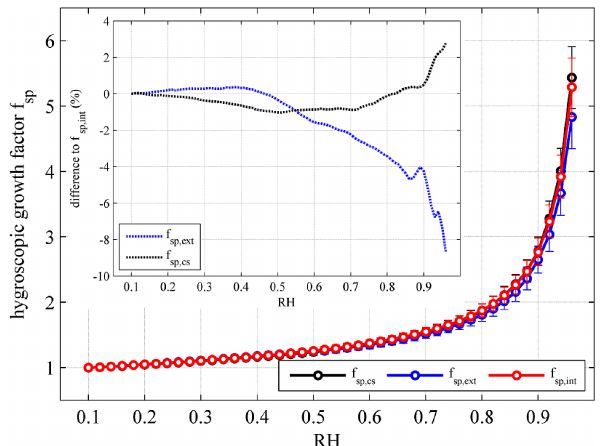
Figure 5. f sp (RH) for the three types of mixed particles and the related difference. The bars stand for one standard